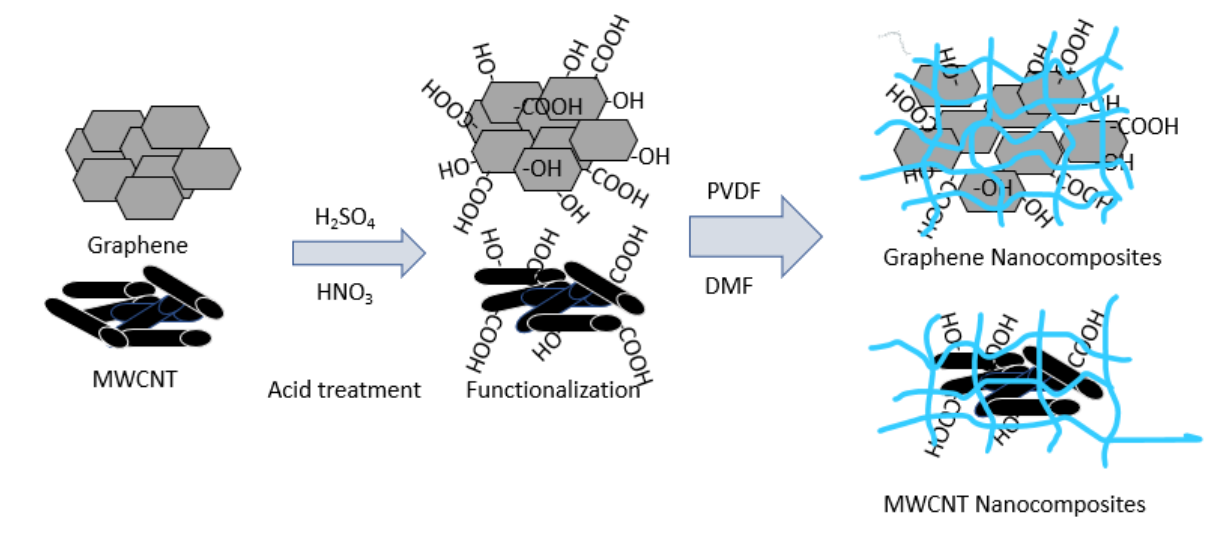
Figure 3. Schematic representation of the preparation of MWCNT/GNF-PVDF nanocomposites. Table 1. Nomenclature of the prepared samples. Sl. No